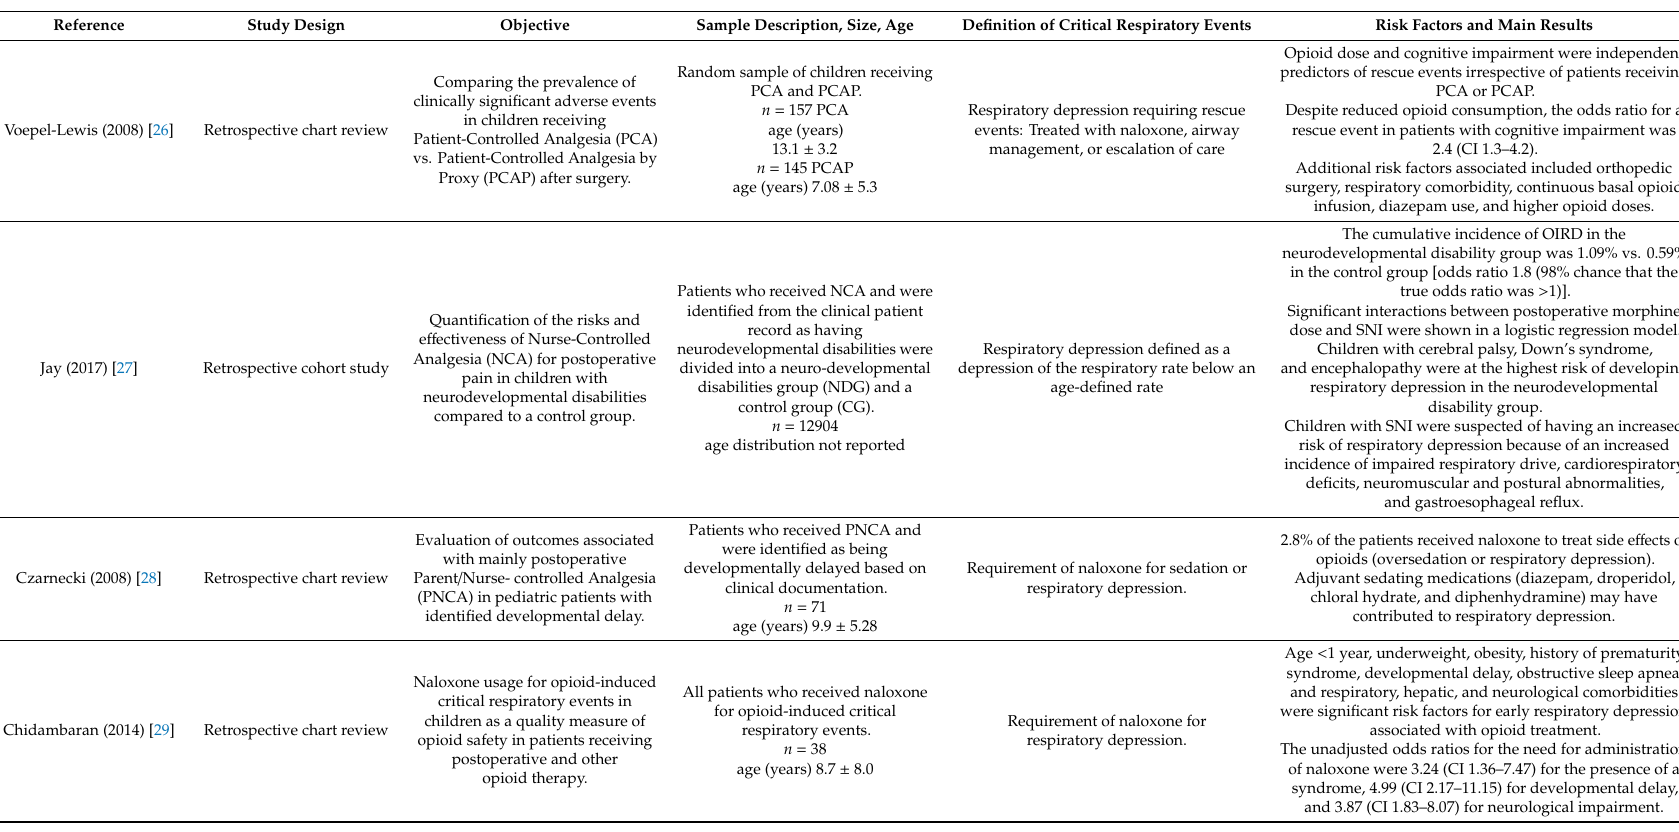
Table 2. Studies reporting on Opioid-Induced Respiratory Depression (OIRD) in children and adolescents with Severe Neurological Impairment